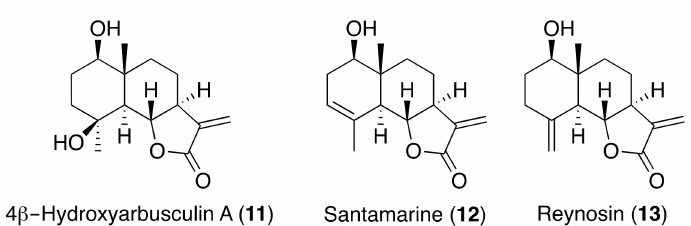
Figure 1. Sesquiterpene compounds isolated from Palythoa aff. clavata